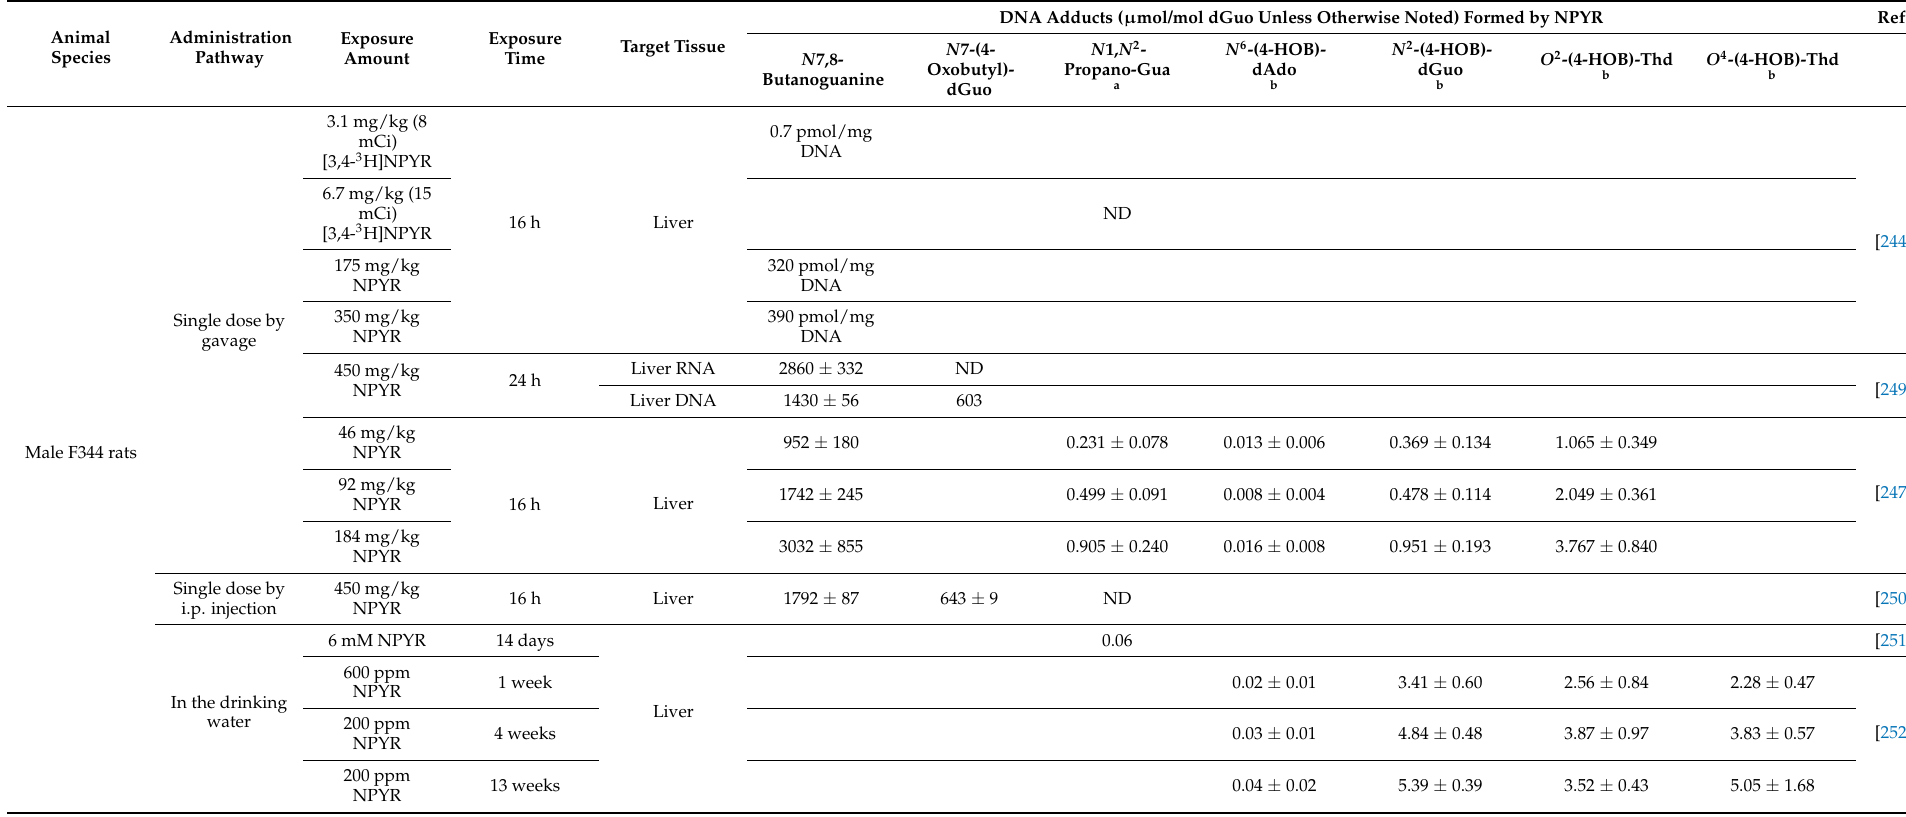
Table 1. Levels of DNA adducts in the tissues of laboratory animals exposed to